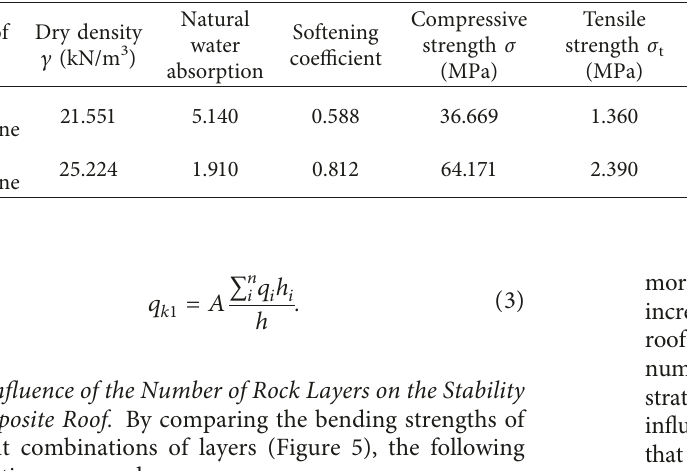
YellowLoading Black